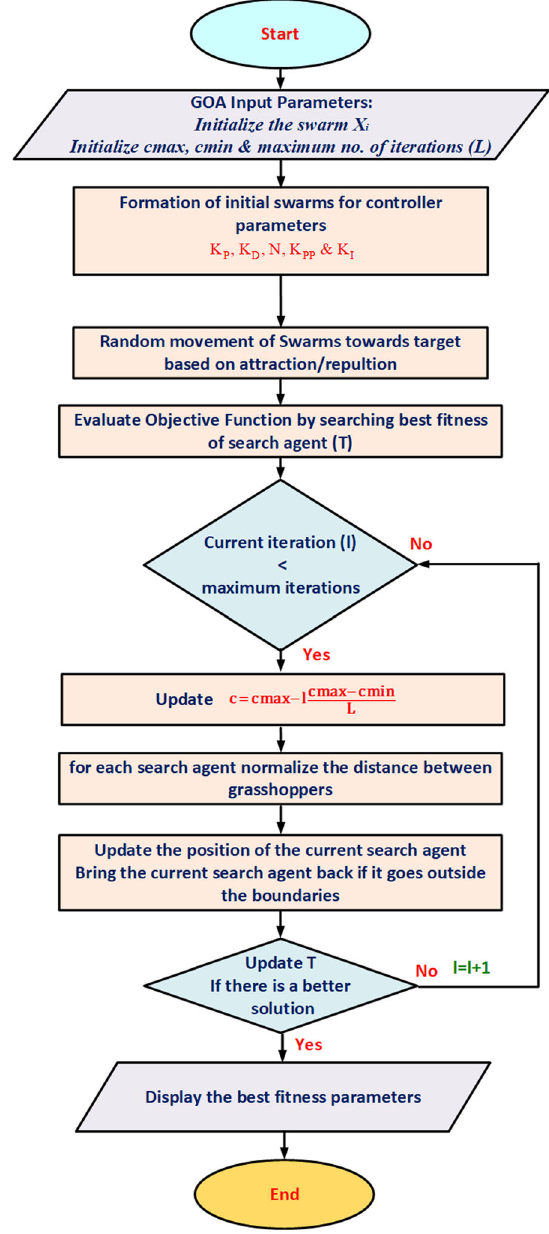
Fig. 3 The flowchart representation of